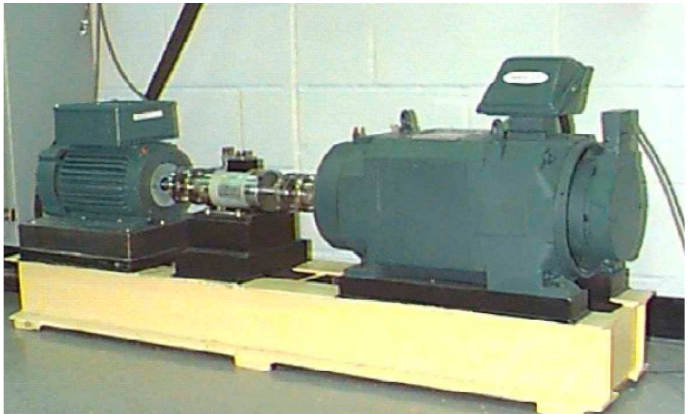
Table 1. Dimensions of the drive roller bearings.